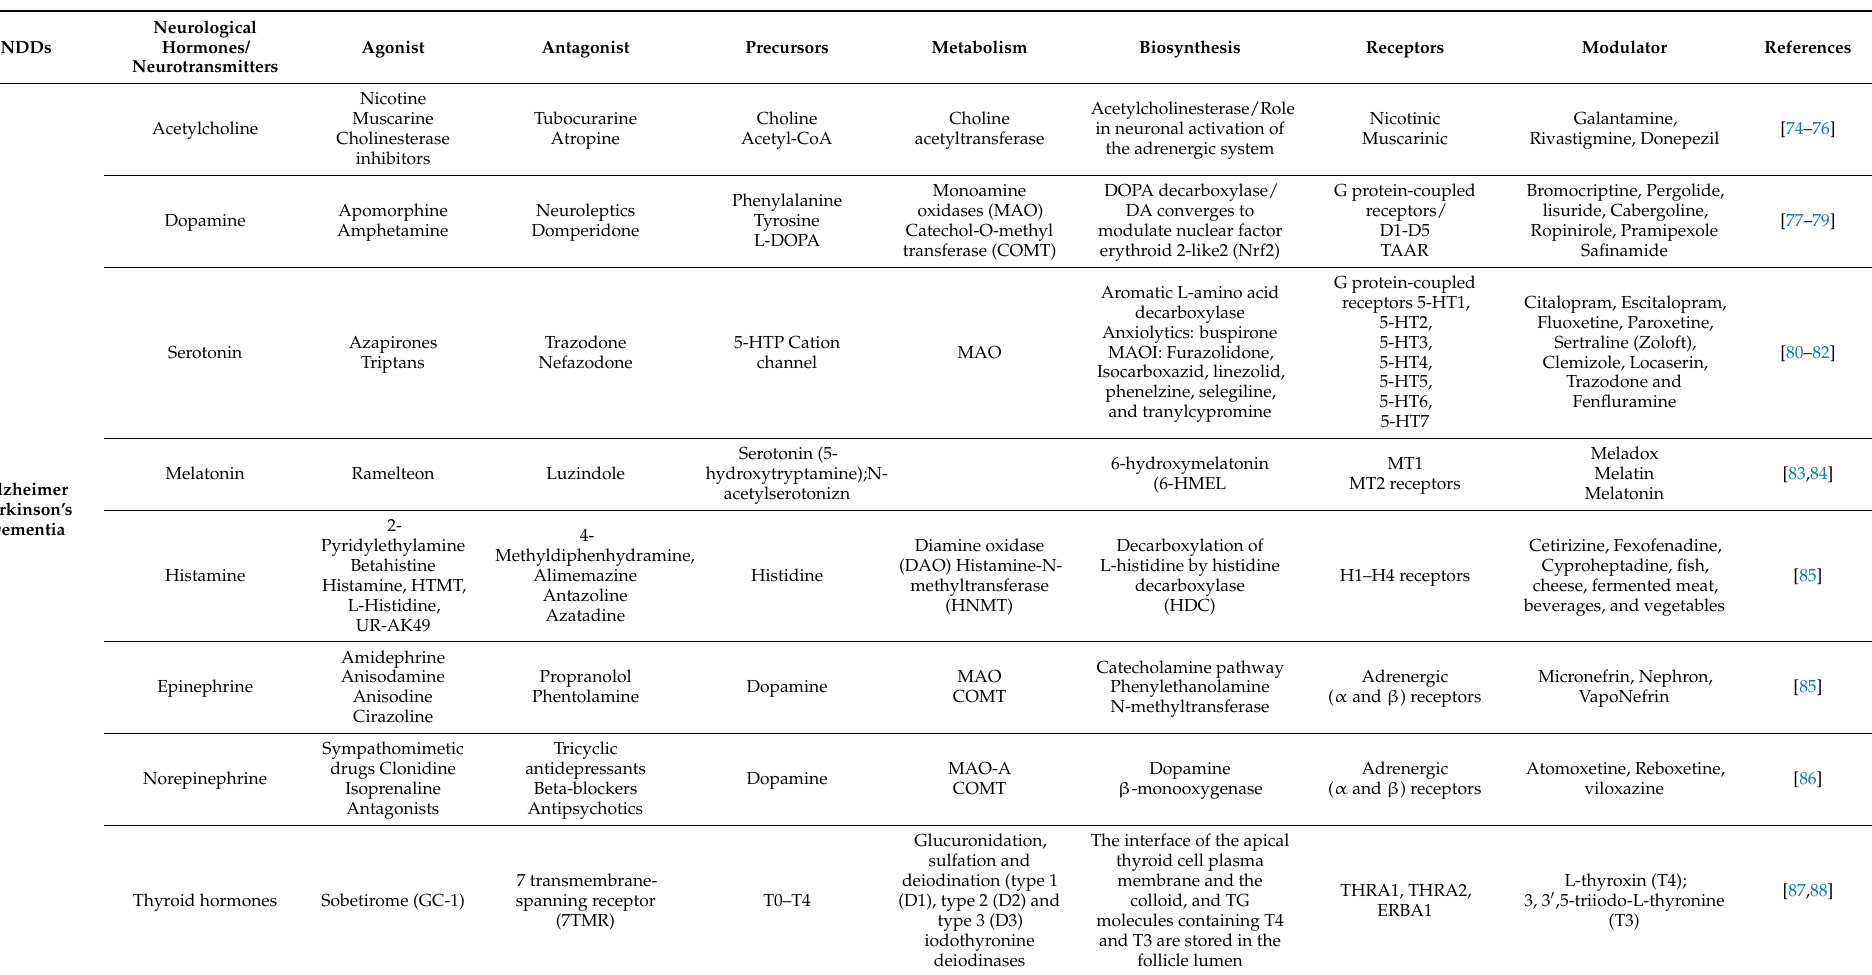
Table 1. Summary of some neuronal hormones and neurotransmitters associated with key